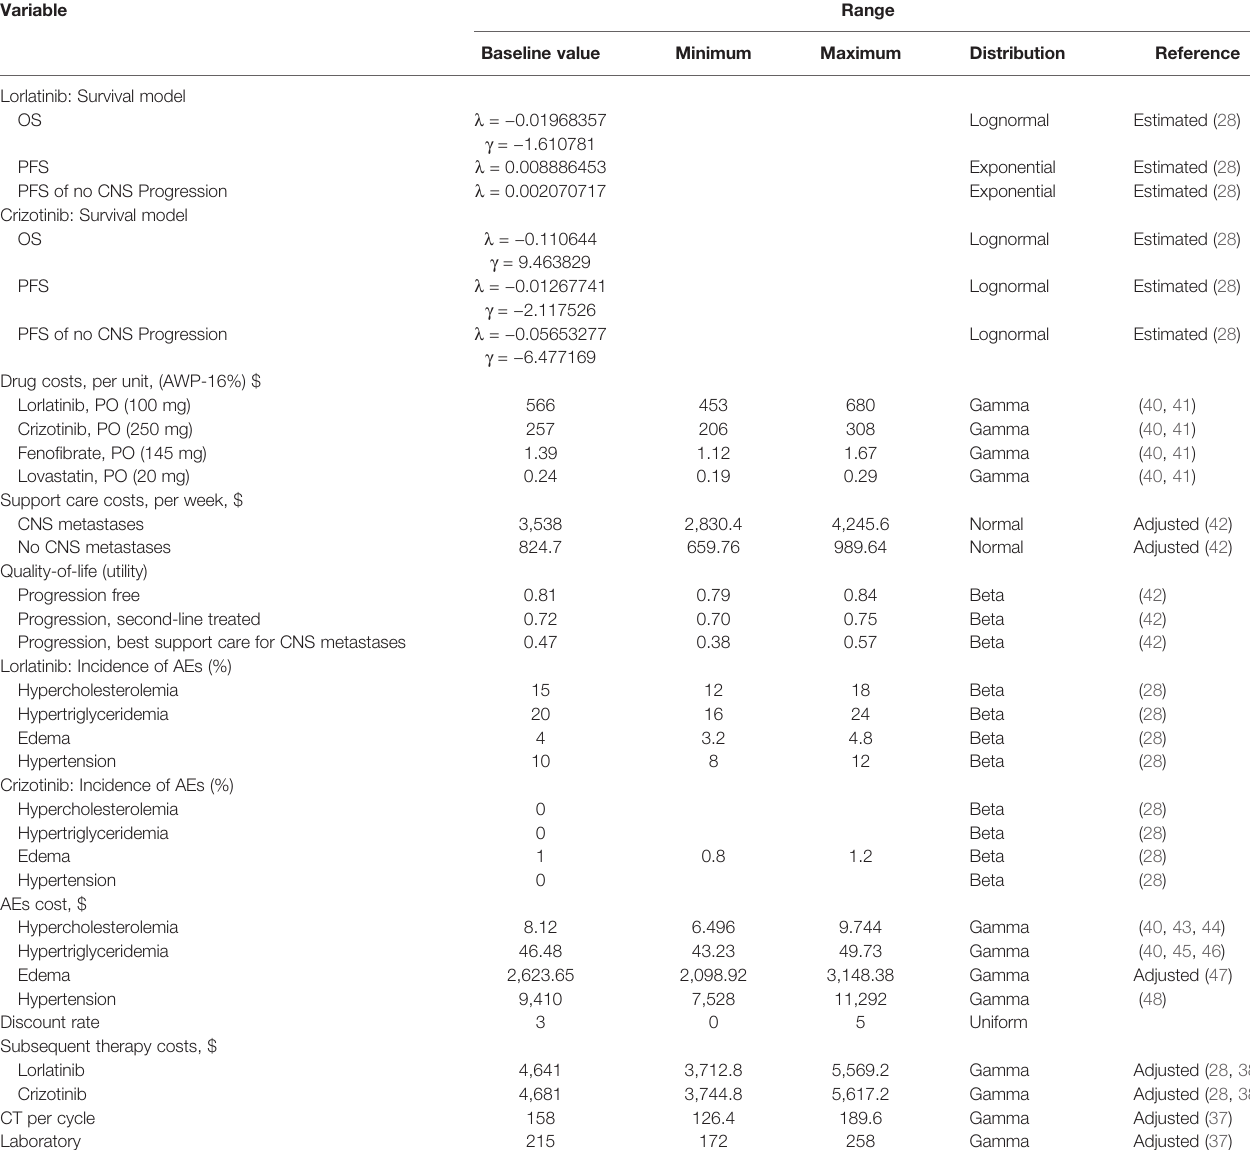
TABLE 1 | Model parameters: baseline values, ranges, and distributions for sensitivity